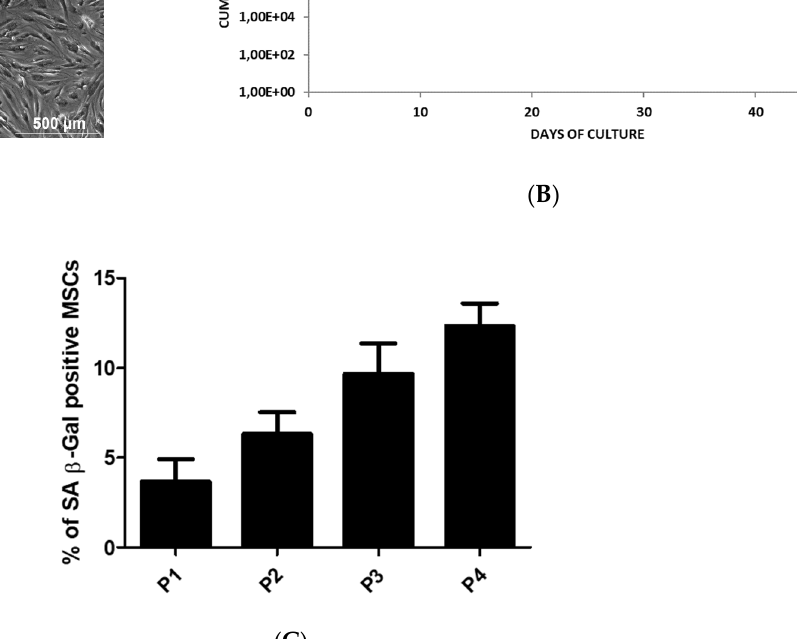
Figure 1. The culture characteristics of adipose MSCs. MSCs are derived from liposuction waste material. The cells are obtained by Gradient Ficoll Centrifugation and cultured by classical adherent method. ( A ) The image is representative for the morphology of MSCs. The cells are observed by light microscopy. Scale bar = 500 µm. ( B ) The cumulative cell number of MSCs at each passage as a function of culture time. ( C ) The percentage of SA β-Gal positive MSCs during passage expansion.